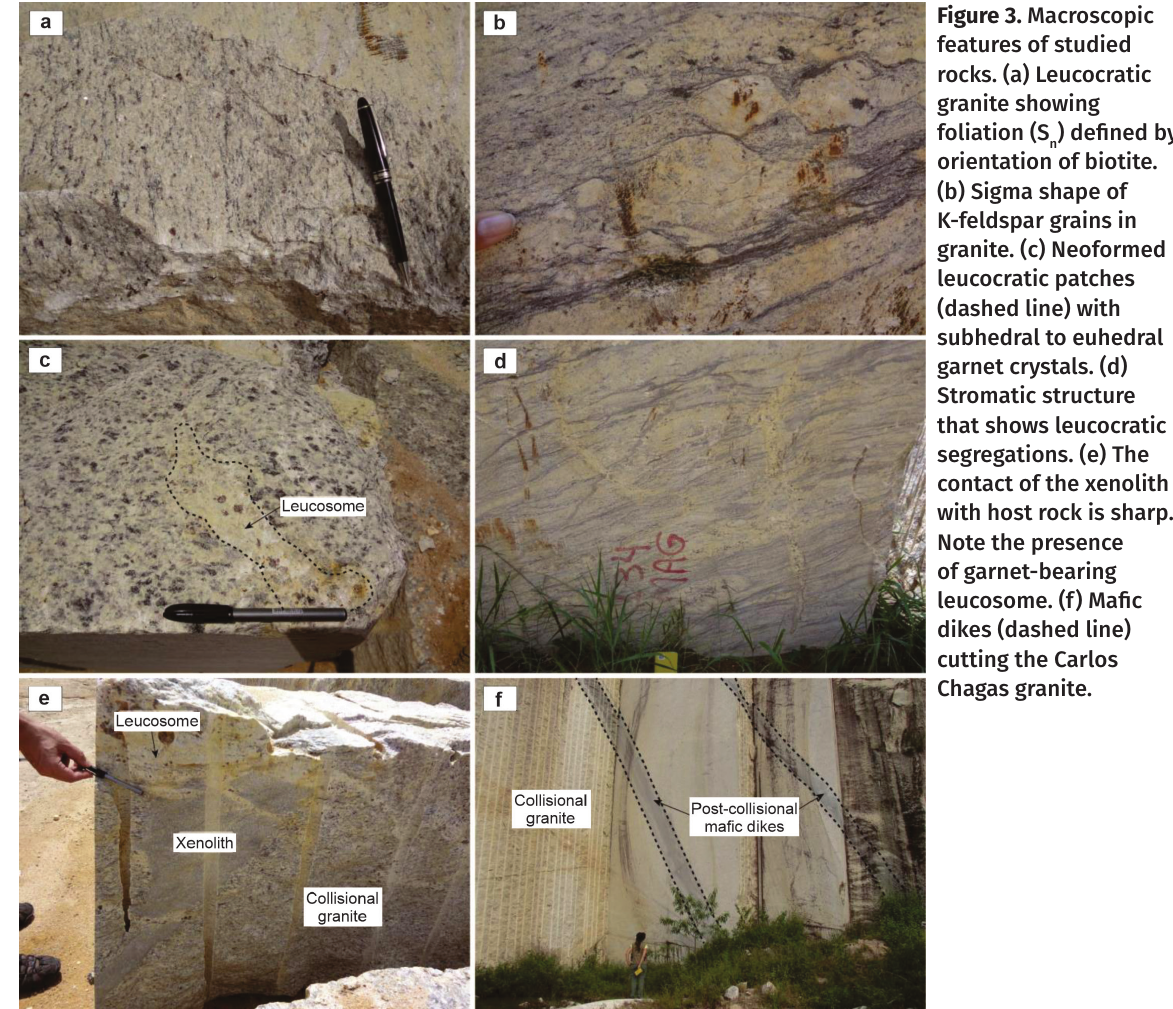
(Figure 5h). The quartz grains commonly exhibit undulose extinction (Figure 6a), subgrains and new grains. Some plagioclase grains exhibit undulose extinction (Figure 6b) and subgrain boundaries. Microfractures filled with quartz are observed cutting K-feldspar grains (Figure 6c).